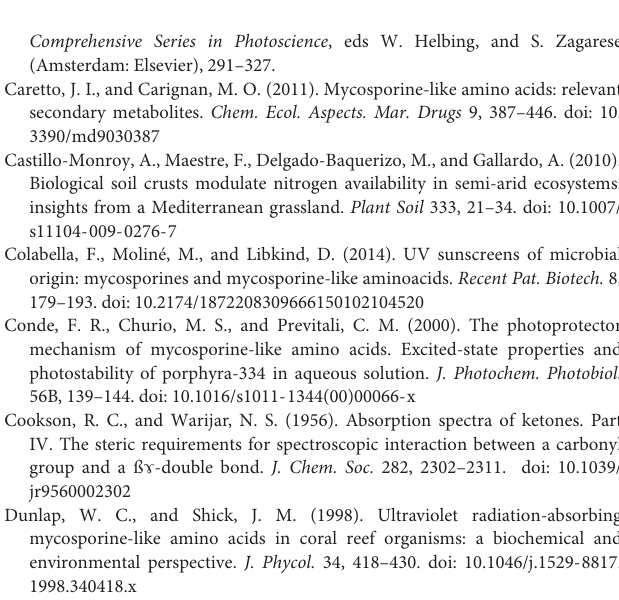
FIGURE S2 | LC-MS spectra of the crude aqueous extract of Klebsormidium crenulatum . Separation was carried out on a YMC-Triart C-18 column